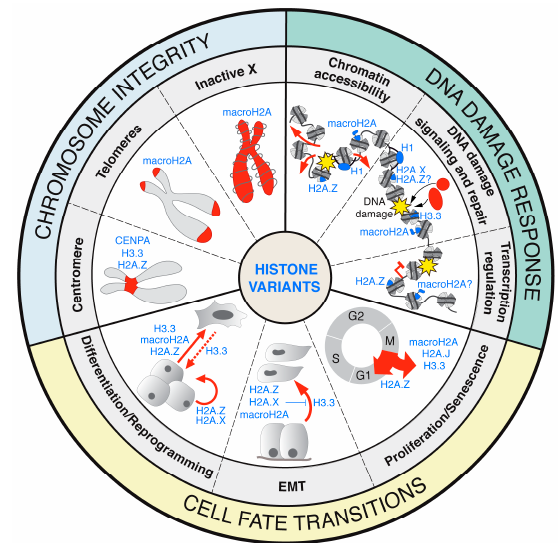
Figure 1. Hallmarks of histone variant contributions to the maintenance of genome integrity and cell identity. Diagram depicting the roles of histone variants in the maintenance of chromosome integrity (blue), the DNA damage response (green), and cell fate transitions (yellow). In each case, key features impacted by histone variants are highlighted in red. EMT: epithelial–mesenchymal transition. 2.1. Histone Variants Define Centromeric and Pericentromeric Regions Driving Chromosome Segregation While most of the genomic DNA is packaged with canonical histones, a subset of chromosomal regions is delineated by specific histone variants. One prominent example is the centromeric histone H3 variant CENPA, which is deposited by the Holliday junction recognition protein (HJURP) [18,19] and defines centromere identity and functions [20]. Supporting this, deletion of the CENPA gene in mouse embryos impairs the recruitment of centromere components required for kinetochore assembly, resulting in mitotic defects and chromosomal aberrations underlying the lethality of CENPA null offspring [21]. In human cells, CENPA ensures proper replication of centromeric repeats, thus preventing centromere breakage and aneuploidy [22]. Overexpression of human CENPA is also a driver for genome instability due to the mislocalization of CENPA-containing nucleosomes on chromosome arms with severe consequences on chromosomal segregation in mitosis [23–26]. Note that overexpression of CENPA and HJURP have been reported in several cancers ([27] and detailed in Section 4.2), showing that beyond the importance of maintaining CENPA dosage, a tight control of its deposition into chromatin is essential to preserve centromere function, thus safeguarding chromosome integrity. CENPA is not the only histone variant shaping centromeric chromatin in mammals since nucleosomes containing the H2A.Z variant intersperse with CENPA nucleosomes [28]. Like CENPA,